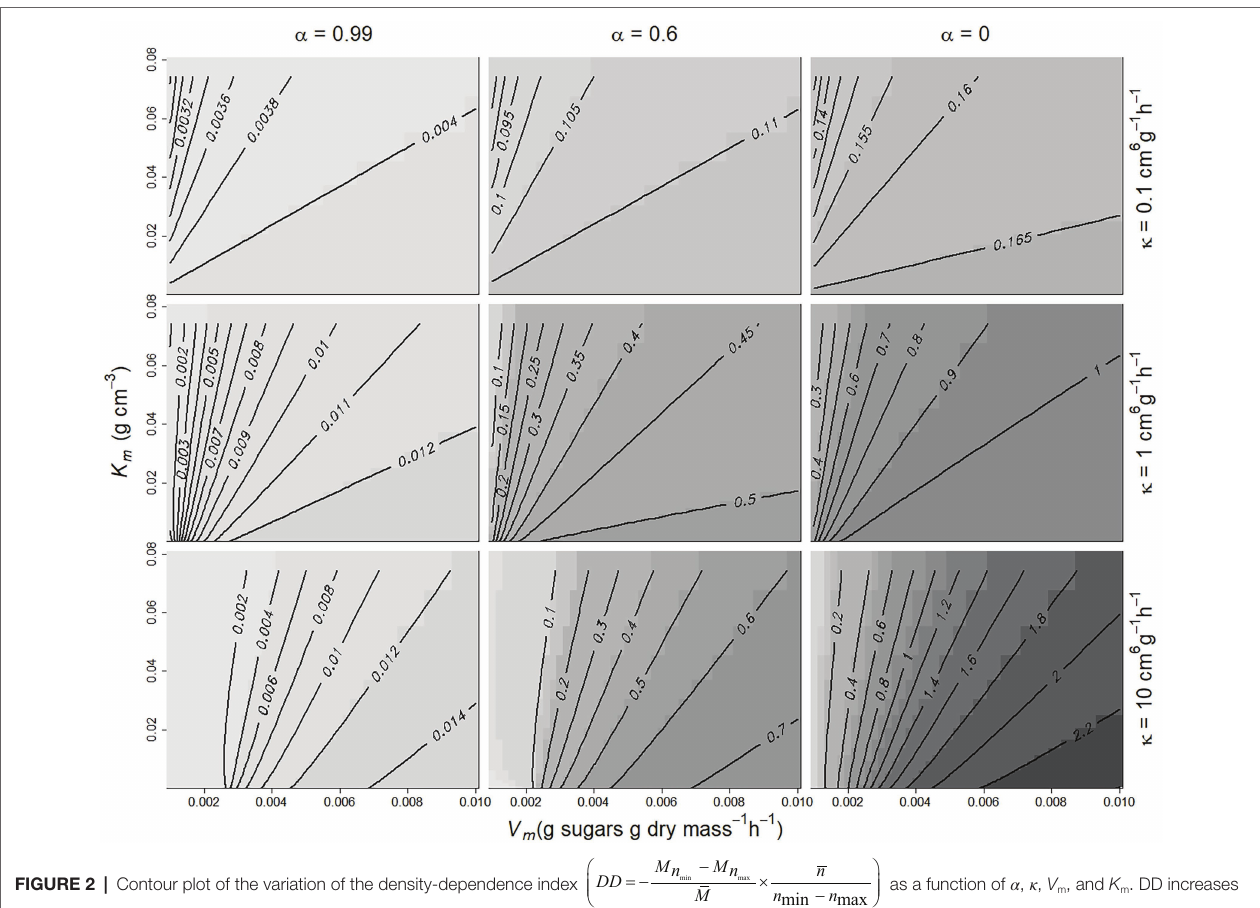
FIGURE 2 | Contour plot of the variation of the density-dependence index min max from light grey to black. Population size ranged from 1 to 20, and growth duration was 50 days, with C = 0.1 g cm − 3 , s 0 = 3 g, DMC =